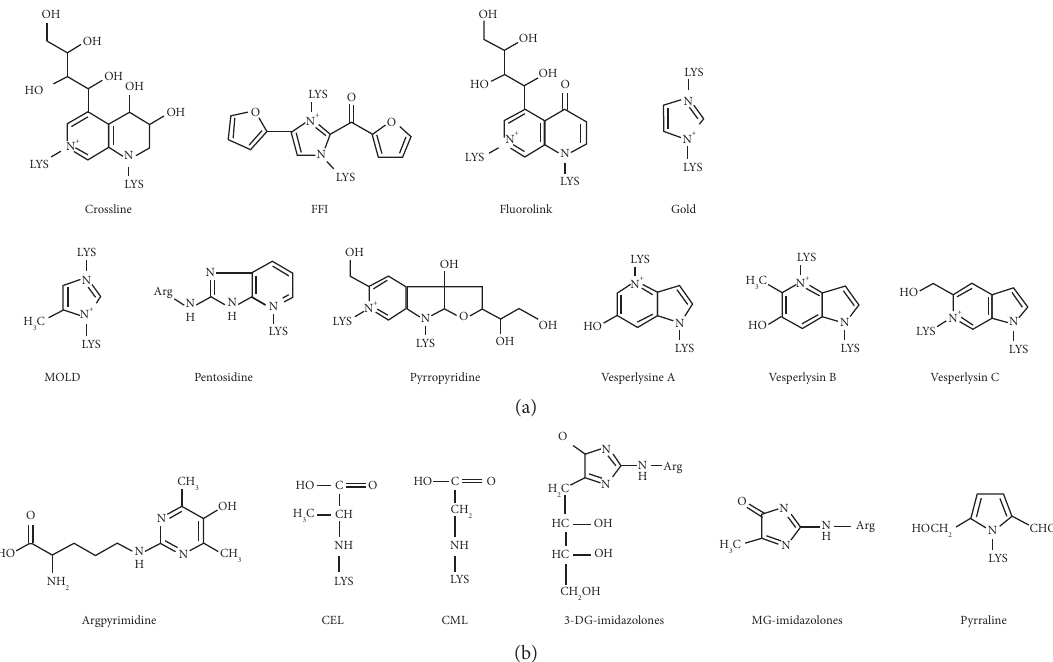
Figure 1: Chemical structures of the two types of ages: (a) fluorescence and cross-linking ages and (b) nonfluorescence and non-cross- linking ages